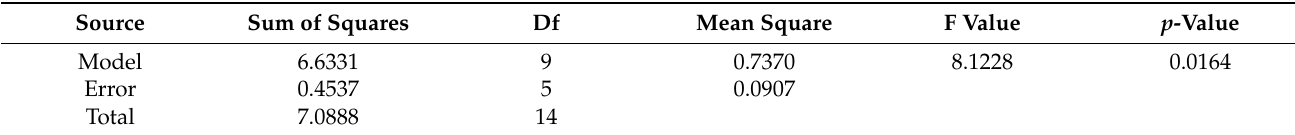
Table 6. Analysis of variance of the regression